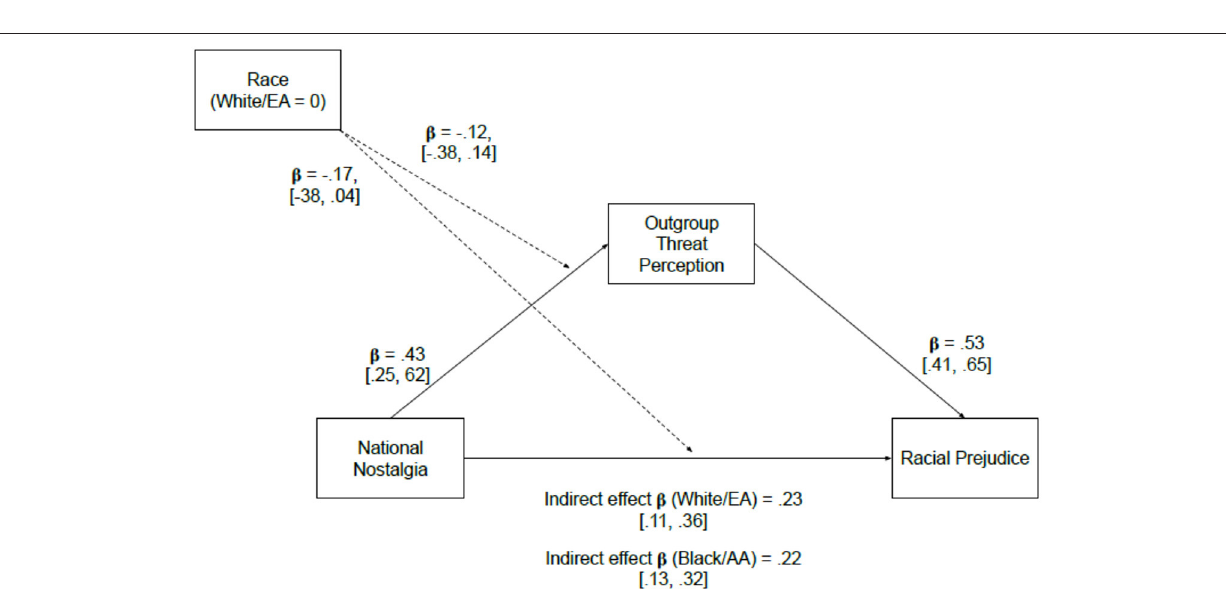
β = 0.18, 95% bias-corrected CI (0.10, 0.26)].